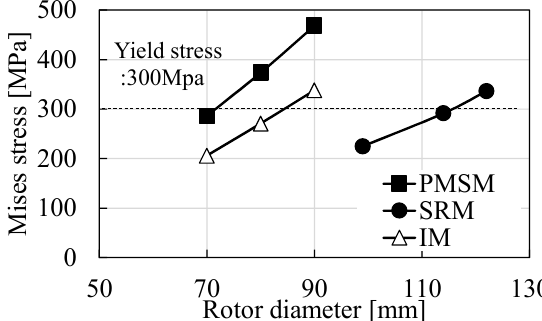
Figure 20. Comparison of Mises stress at the maximum speed of 52,000 min − 1 .